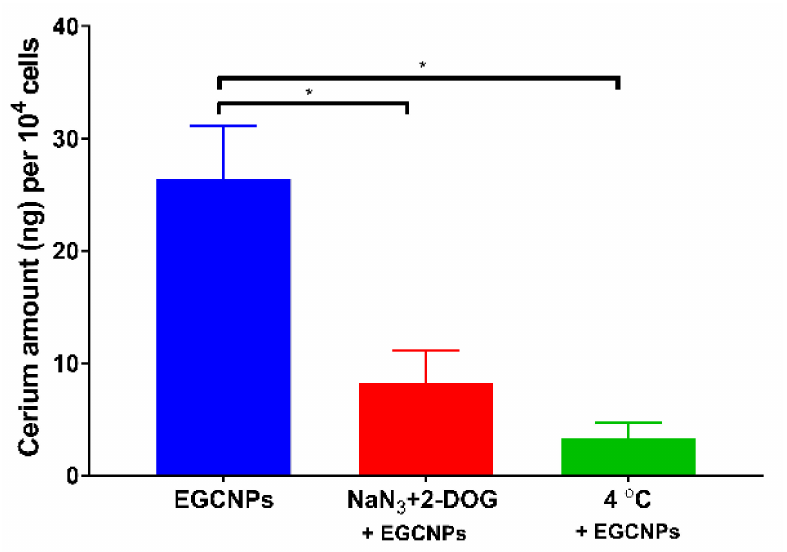
Figure 2. EGCNPs uptake in HLECs for two experimental conditions that inhibit endocytosis compared to negative controls. The reduced amount of cerium in cells for both conditions compared to controls is statistically significant indicating an endocytosis-dependent mechanism of EGCNP uptake. Asterisks denote statistical significance ( n = 3, p < 0.05, one-way ANOVA). Error bars are presented as means ±